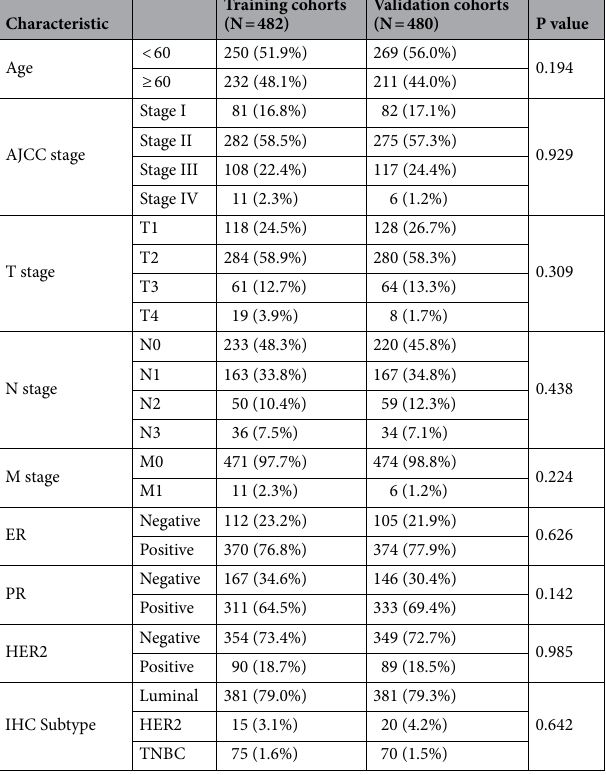
Table 1. Clinical characteristics of patients in training and validation cohorts.